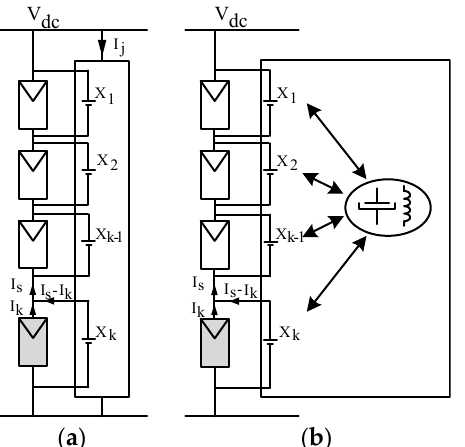
Figure 16. Conceptual PV generation control circuit: Type A operated on output terminal power ( a ); Type B operated on autonomous power ( b ) [37].